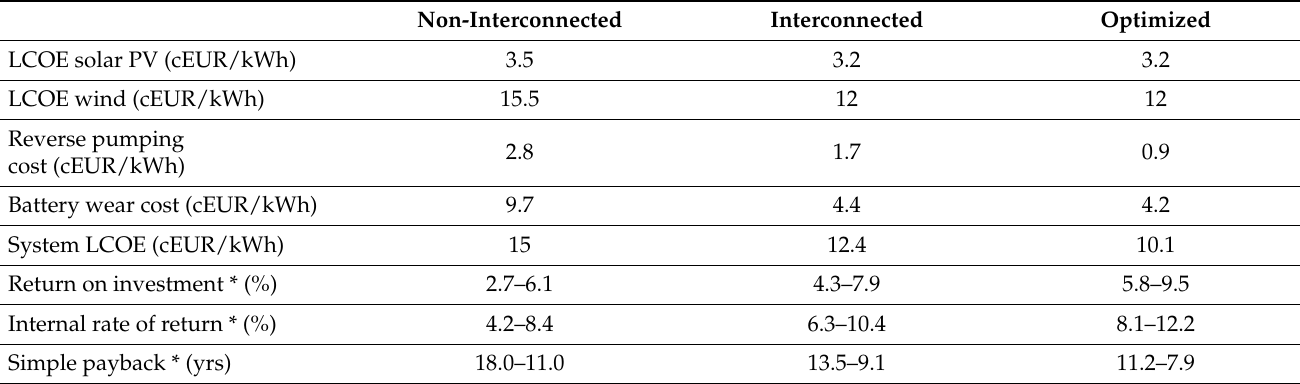
Table 16. Initial capital, replacement, O&M, and total costs for the three generation